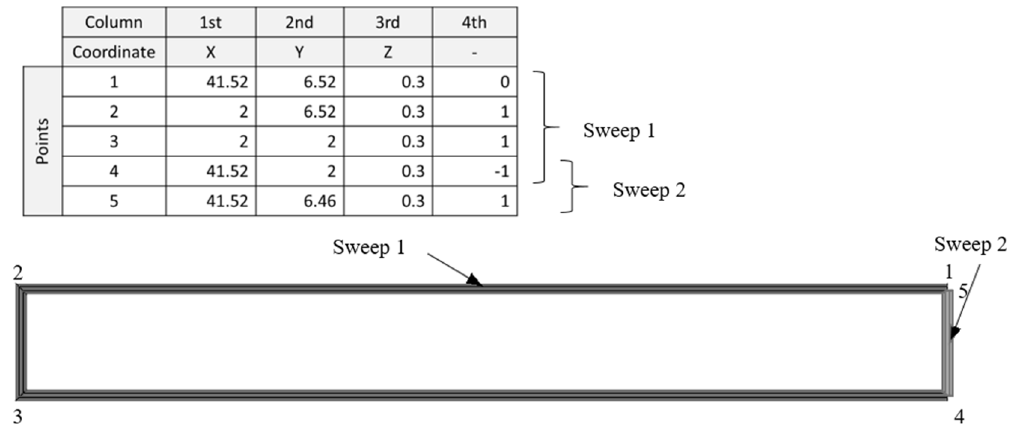
Figure 9. Close sweep in modelling by sections.